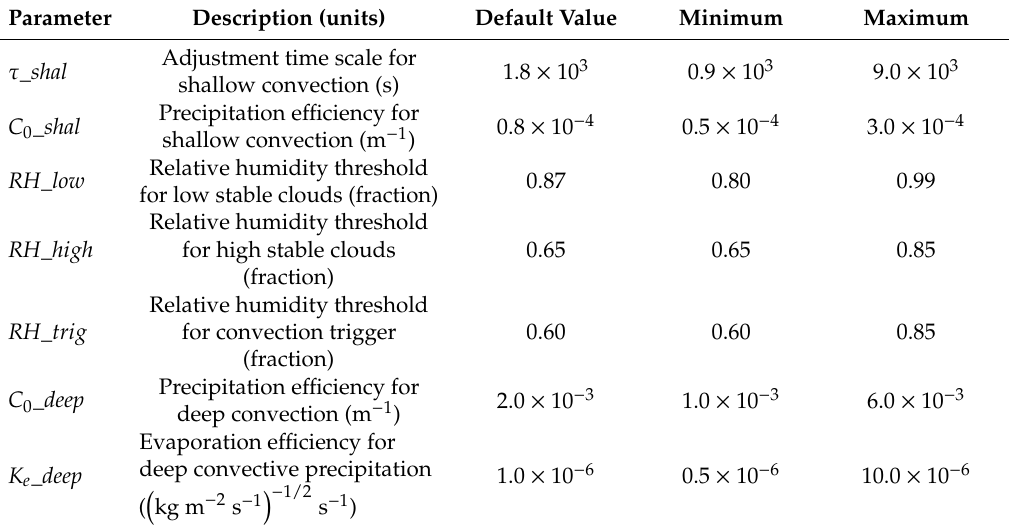
Table 1. Description, default values and perturbed ranges of seven parameters in the model, adopted from Liu et al.